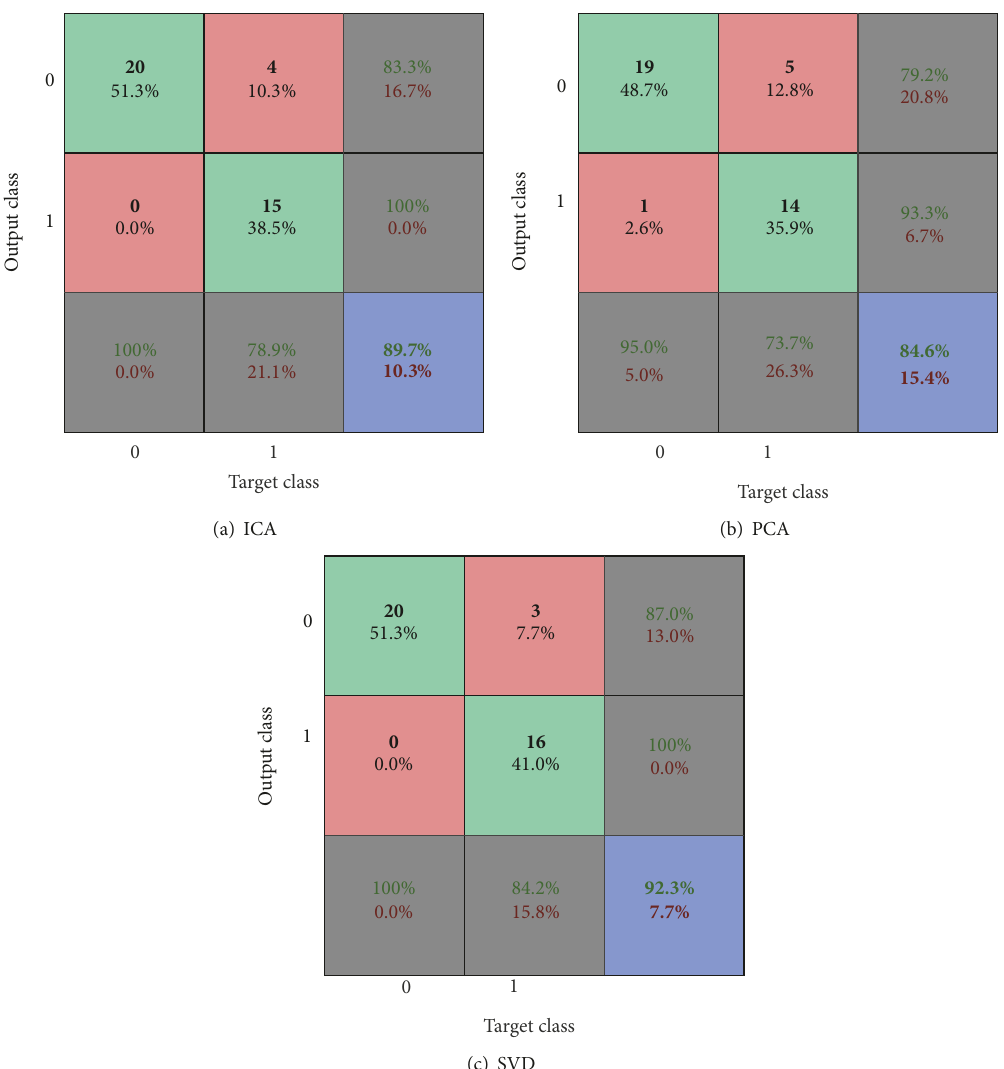
Figure 5: Confusion matrices of classification using CART for ICA, PCA, and SVD data reduction techniques.